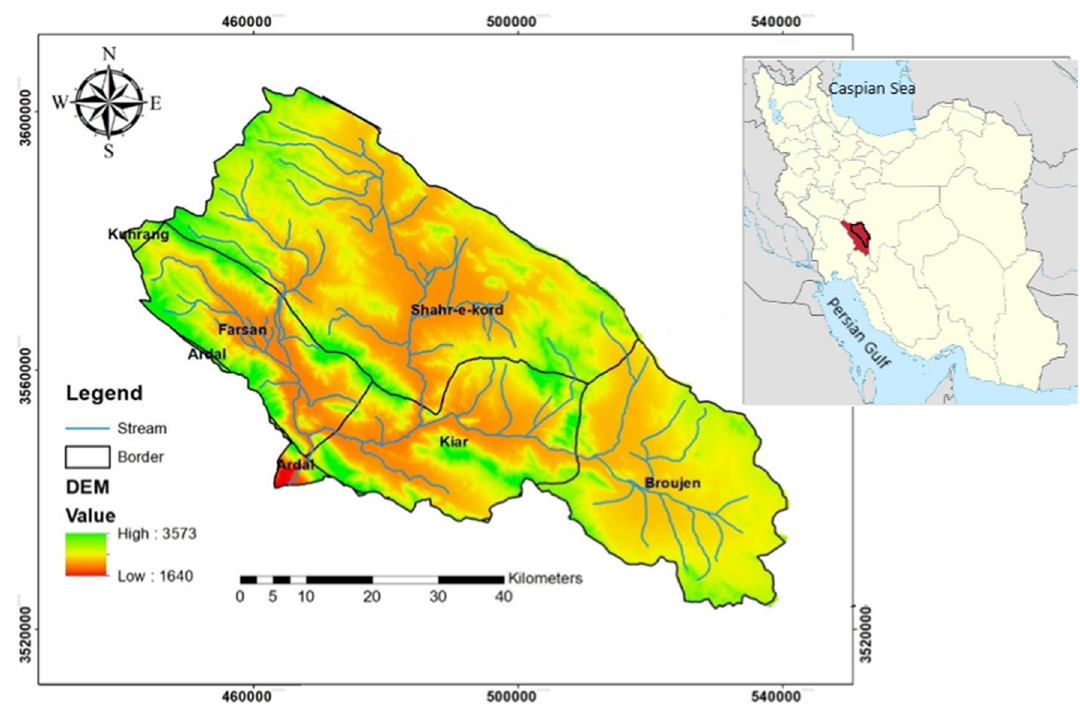
Fig. 1 Location of Beheshtabad Watershed (Black Boundary) in Chaharmahal and Bakhtiari Province (Red Area),